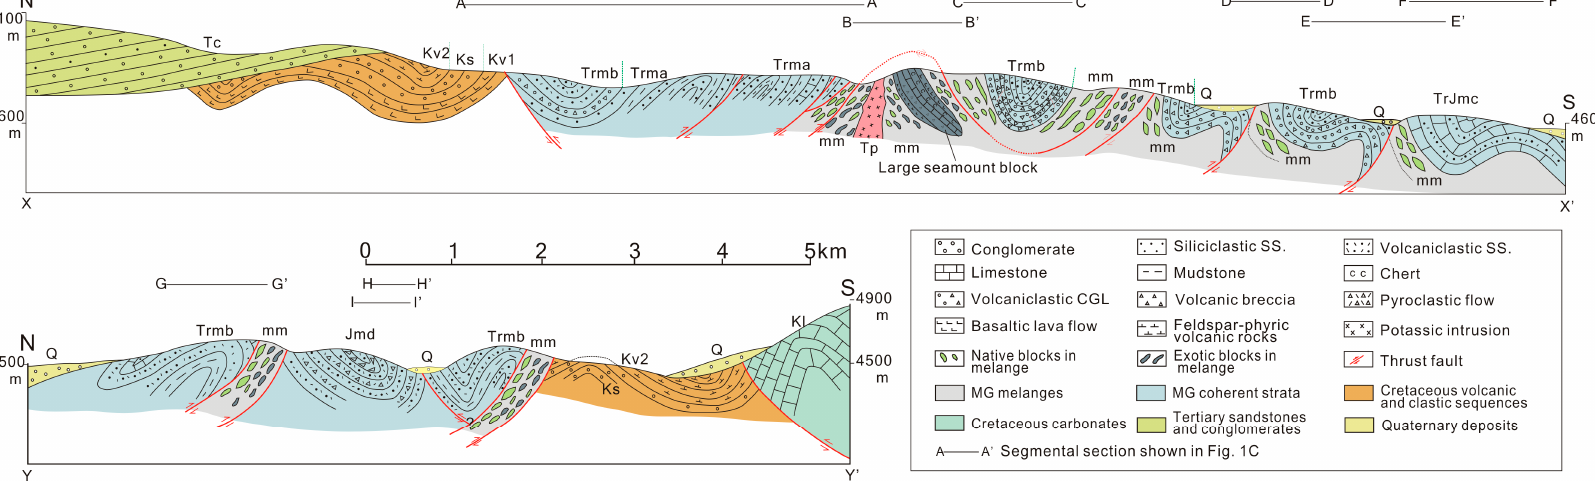
Figure 2. Composite cross-sections (X–X’ and Y–Y’) constructed based on the segmental sections through the studied traverse. Location of the sections is shown in Figure 1C. See text for details (Modified from [17]).